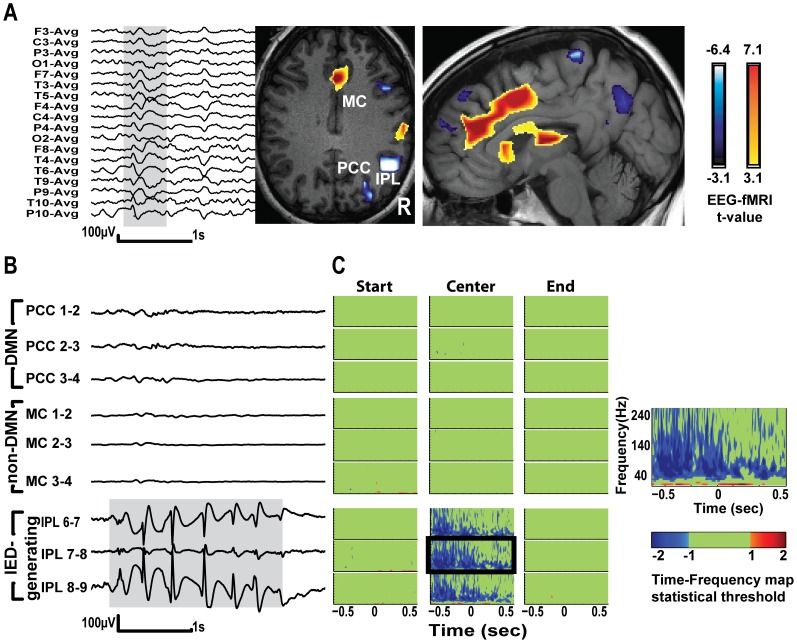
EEG-fMRI results and Time-Frequency (TF) statistical maps of SEEG recordings from patient 3.A – Scalp EEG showing right temporo-parietal IED (spike and slow wave) and the associated BOLD changes. Most significant deactivation (t = -6.7) is in right IPL and concordant with the spike field. Smaller deactivations are in posterior pre-cuneus and frontal and parietal regions ipsilateral to the IED. Activations are in the cingulate gyri, thalami and ipsilateral central region. B - SEEG traces showing typical runs of spike and slow waves in right IPL (lower 3 traces) and in right PCC and middle cingulate (MC). C – TF plots comparing IEDs and baseline in PCC, MC and the channels with IEDs (IPL). The IPL is the spiking channel and part of the DMN. TF maps centered at the center of IED run show decrease in gamma in the channels with IEDs (IPL). Boxed TF map is shown in higher magnification on the right and demonstrates power decrease in 40–160 Hz band, and increase in frequencies <30 Hz.